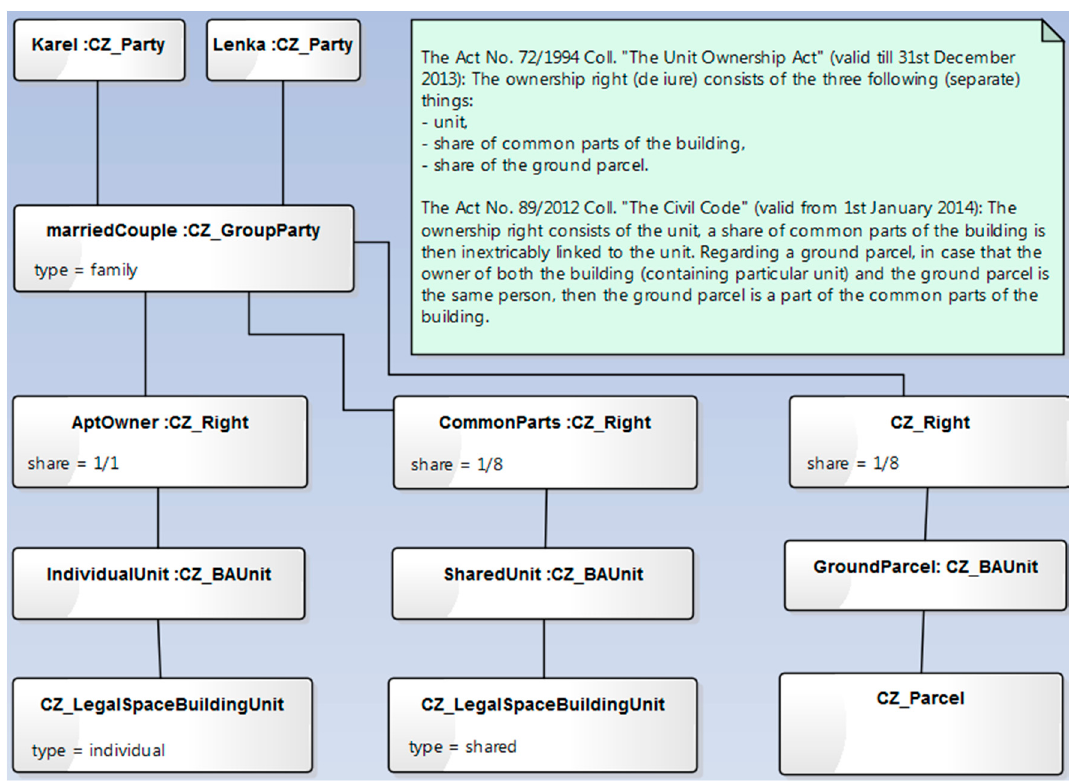
Figure 7. Ownership of a building unit. In principle, the owner has a right to the individual unit, a share of common components and a land parcel (but the owner of the unit and the owner of the land parcel could be different people).